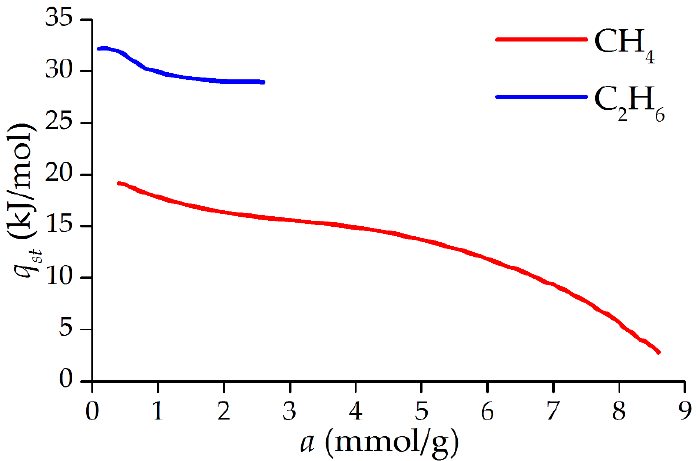
Figure 8. Differential molar isosteric heat of adsorption of methane and ethane on the microporous carbon adsorbent ACPK at a temperature of 293 K, determined from experimental data.